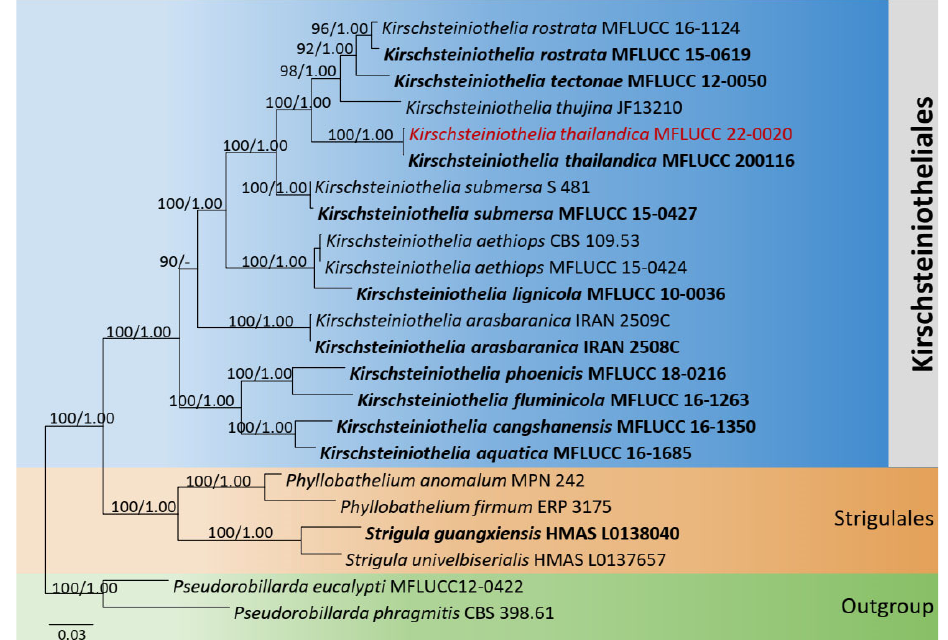
Figure 5. Phylogram generated from maximum likelihood analysis is based on combined LSU, SSU, and ITS sequence data. Related sequences of Kirschsteiniothelia species were obtained from Sun et al. [38]. ML bootstrap values equal to or greater than 75% and Bayesian posterior probabilities (BYPP) equal to or greater than 0.95 are indicated above the branches. The tree was rooted to Pseudorobillarda eucalypti (MFLUCC 12 ‐ 0422) and P. phragmitis (CBS 398.61). The newly generated sequences are indicated in red. Type and ex ‐ type strains are in bold.